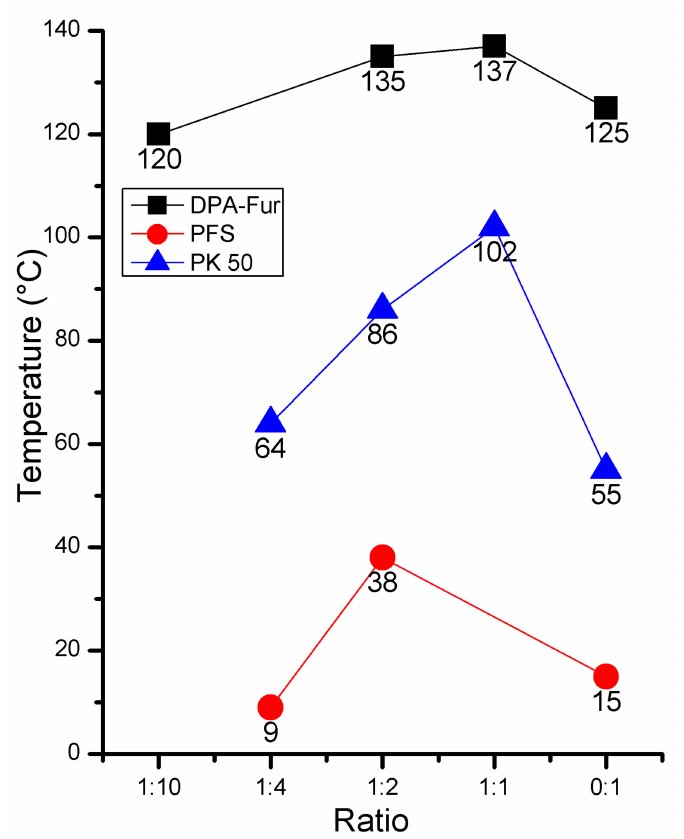
Figure 6. Softening temperature of various DA systems for varying MAL:FUR ratios (0:1 refers to the uncrosslinked